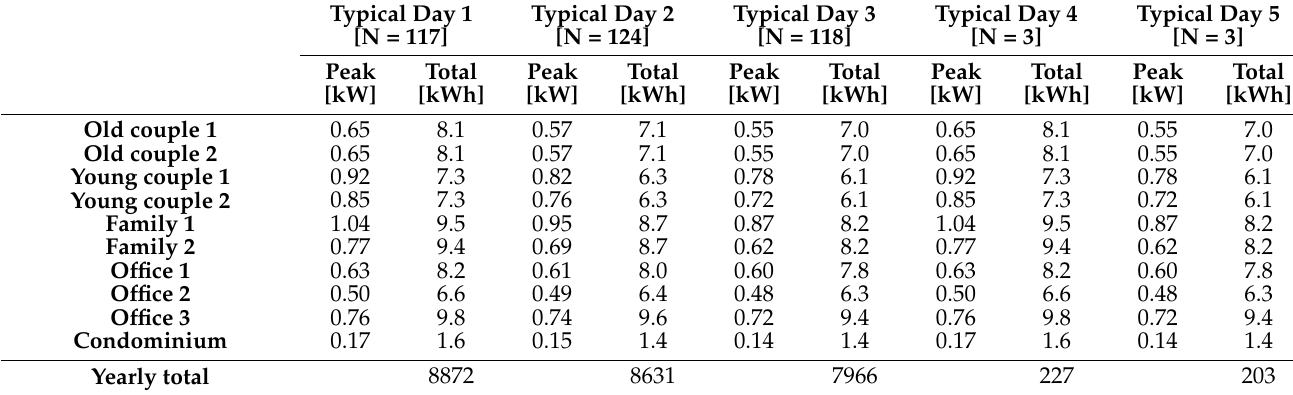
Table 3. Electricity demand for each apartment in each typical day, in terms of peak and total electricity demand during the day. The yearly total demand is calculated by multiplying the total electricity demand of each typical day for its cardinality (N, according to the nomenclature used in Equation (6)).